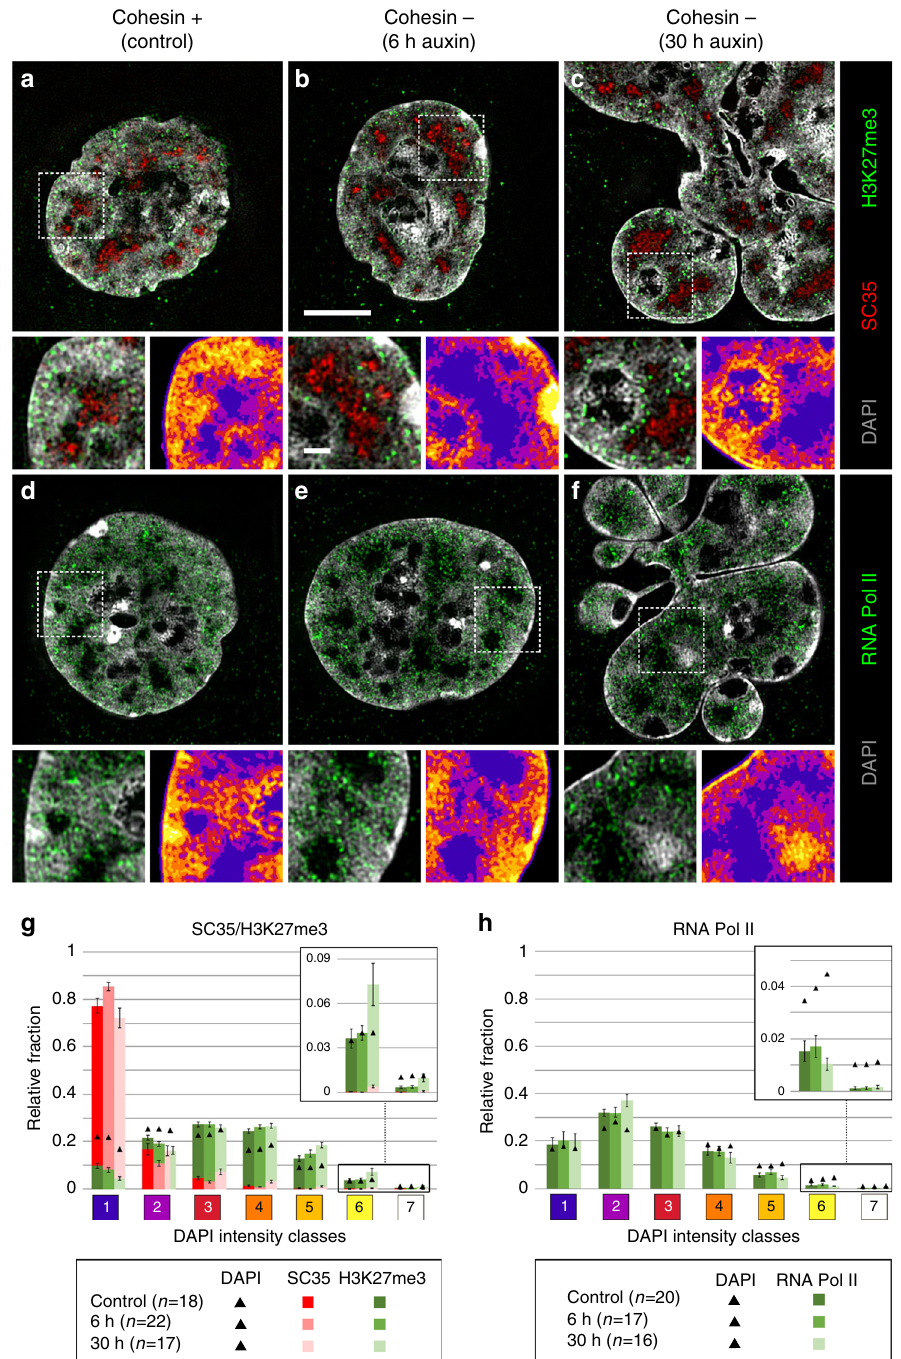
Fig. 4 Congruent 3D topography of SC35, H3K27me3, and RNA Pol II in nuclei of control and cohesin depleted cells. a – f DAPI-stained nuclear mid- sections (gray) displayed from 3D SIM image stacks of control nuclei ( a , d ), of pre-mitotic cohesin depleted nuclei after 6 h auxin treatment ( b , e ), and post-endomitotic MLN after 30 h auxin treatment ( c , f ) reveal the topography of immunostained SC35 (red) and H3K27me3 (green) ( a – c ), and active RNA Pol II (red) ( d – f ). Scale bar: 5 µ m. An enlargement of a representative boxed area is shown beneath each mid-section together with the color-coded DAPI intensity heat map (compare Fig. 3). Scale bar: 1 µ m. SC35 marked splicing speckles are located in the interchromatin compartment (IC, blue), H3K27me3 marks are distributed within neighboring chromatin domain clusters; RNA Pol II is mainly enriched in chromatin lining the IC (purple), but also extends into the IC, whereas it is largely excluded from densely compacted chromatin regions (brown and yellow). g , h 3D image analyses of 3D SIM stacks show the relative fraction of g SC35 (red) and H3K27me3 (green) signals (control: n = 18, 6 h: n = 22, 30 h: n = 17 cells from two independent experiments), and h of active RNA Pol II (green) (control: n = 20, 6 h: n = 17, 30 h: n = 16 cells from two independent experiments) in comparison to DAPI intensity classes 1 – 7 marked as black triangles. 6 and 30 h, respectively, denote incubation time in auxin. Data are represented as mean ± SEM. Source data are provided as a Source Data fi